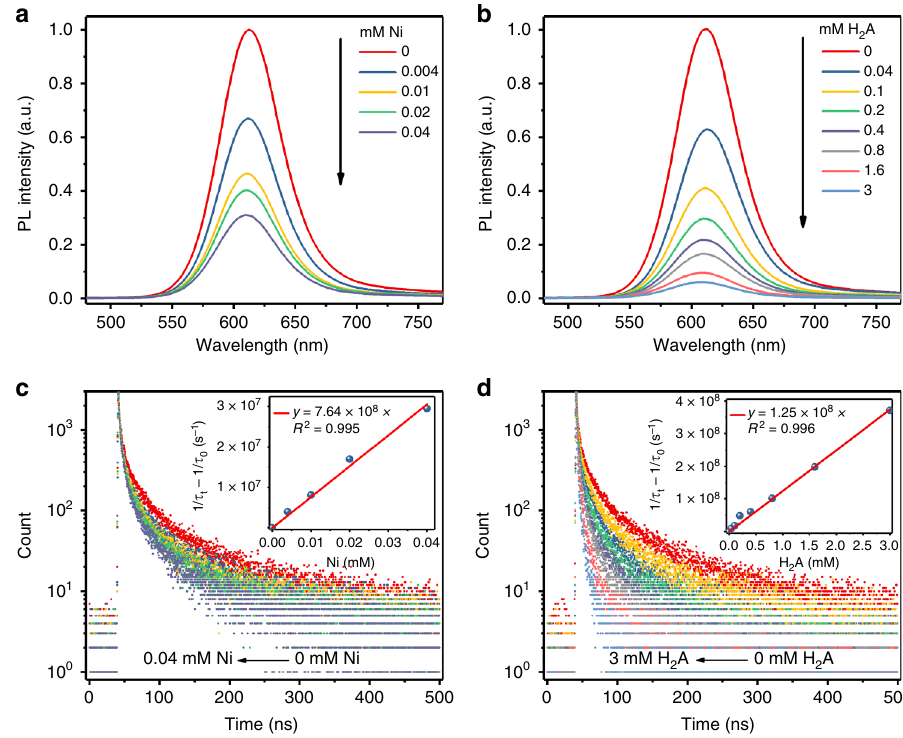
Fig. 4 Steady state and time-resolved photoluminescence quenching experiment of InP/ZnS-S QDs (525 nm, 15 min). a , b Static photoluminescence quenching for InP/ZnS-S QDs in water after addition of different amounts of Ni 2 + and H 2 A. c , d PL decay curves of InP/ZnS-S QDs after addition of different amounts of Ni 2 + and H 2 A respectively; the inset shows the fi tting curve for lifetime changes with increased concentration of Ni 2 + /H 2